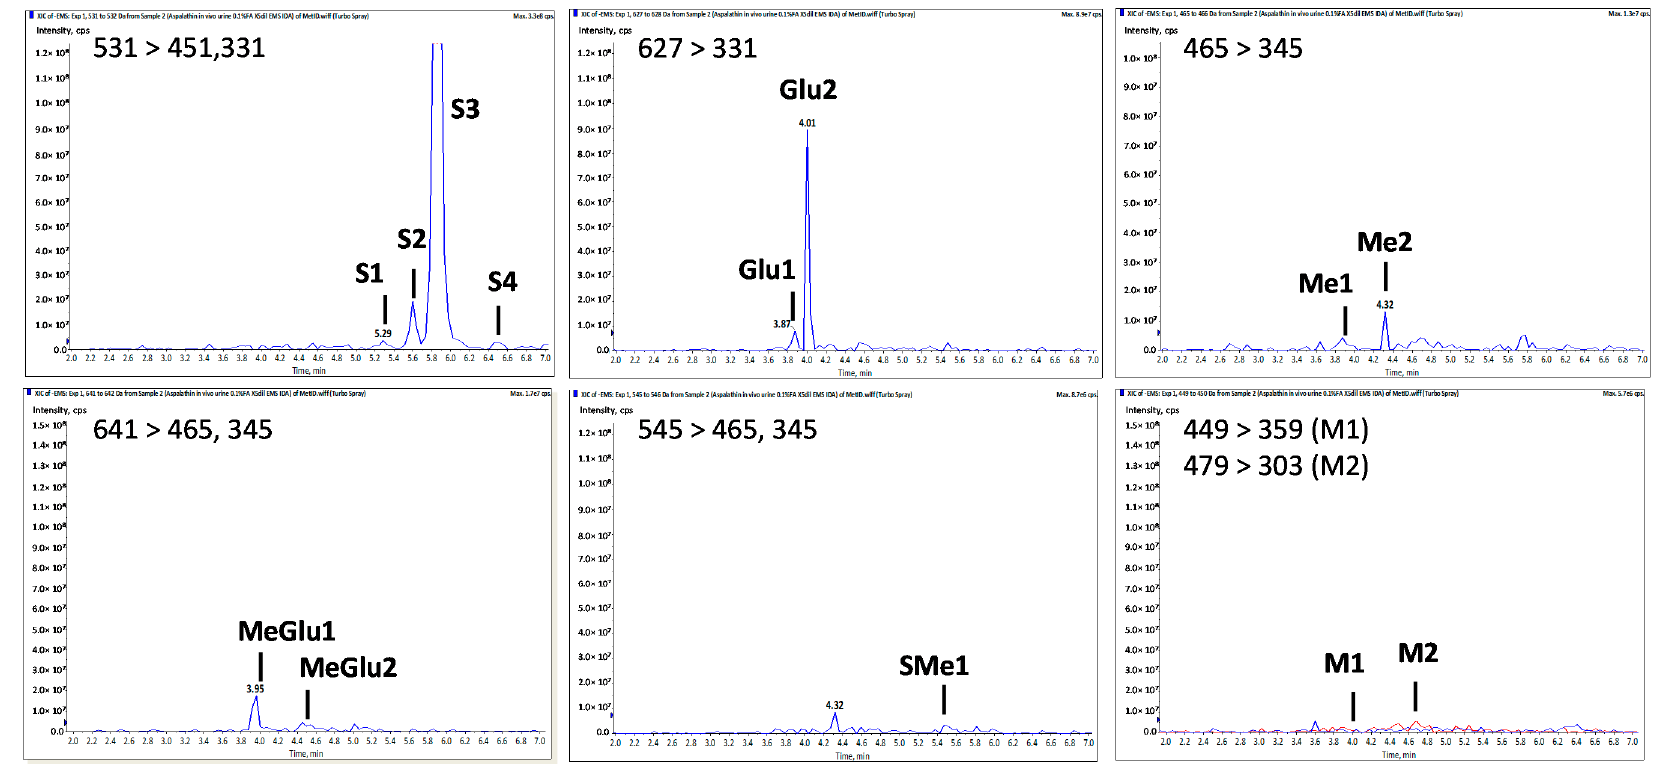
Figure 2. Extracted ion chromatograms of aspalathin metabolites in mouse urine (see Table 5 for peak numbers).